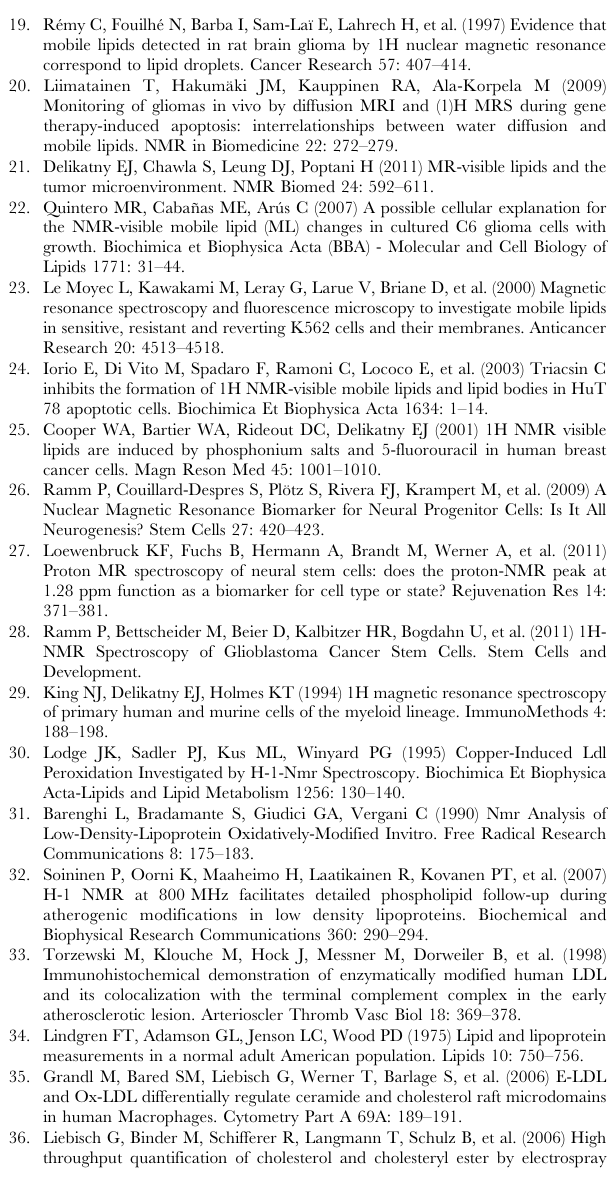
Figure S1 Deconvolution of NMR spectra of macro- phage suspensions. Top: Measured spectrum (thin line) and result of a lorentzian-gaussian fit (thick line). Second from top: Fit components of small molecules, e.g. lactate (lac), alanine (ala), dimethyl-silapentane-sulfonate (DSS), acetate (ace), glutathione (GSH). Third from top: Fit components of NMR-visible lipids, i.e. mobile lipids (ML). Bottom: Model spectrum of NMR-visible proteins, i.e. mobile proteins (MP).